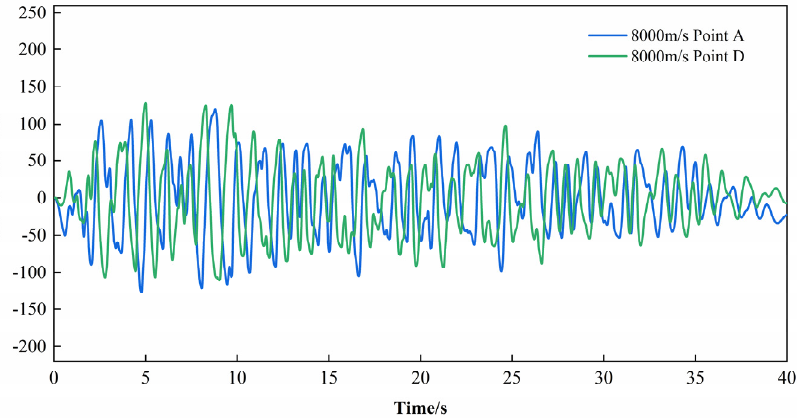
Figure 16. The stress–time-history curve of the rail at point A and point D when the apparent wave velocity is 8000 m/s.